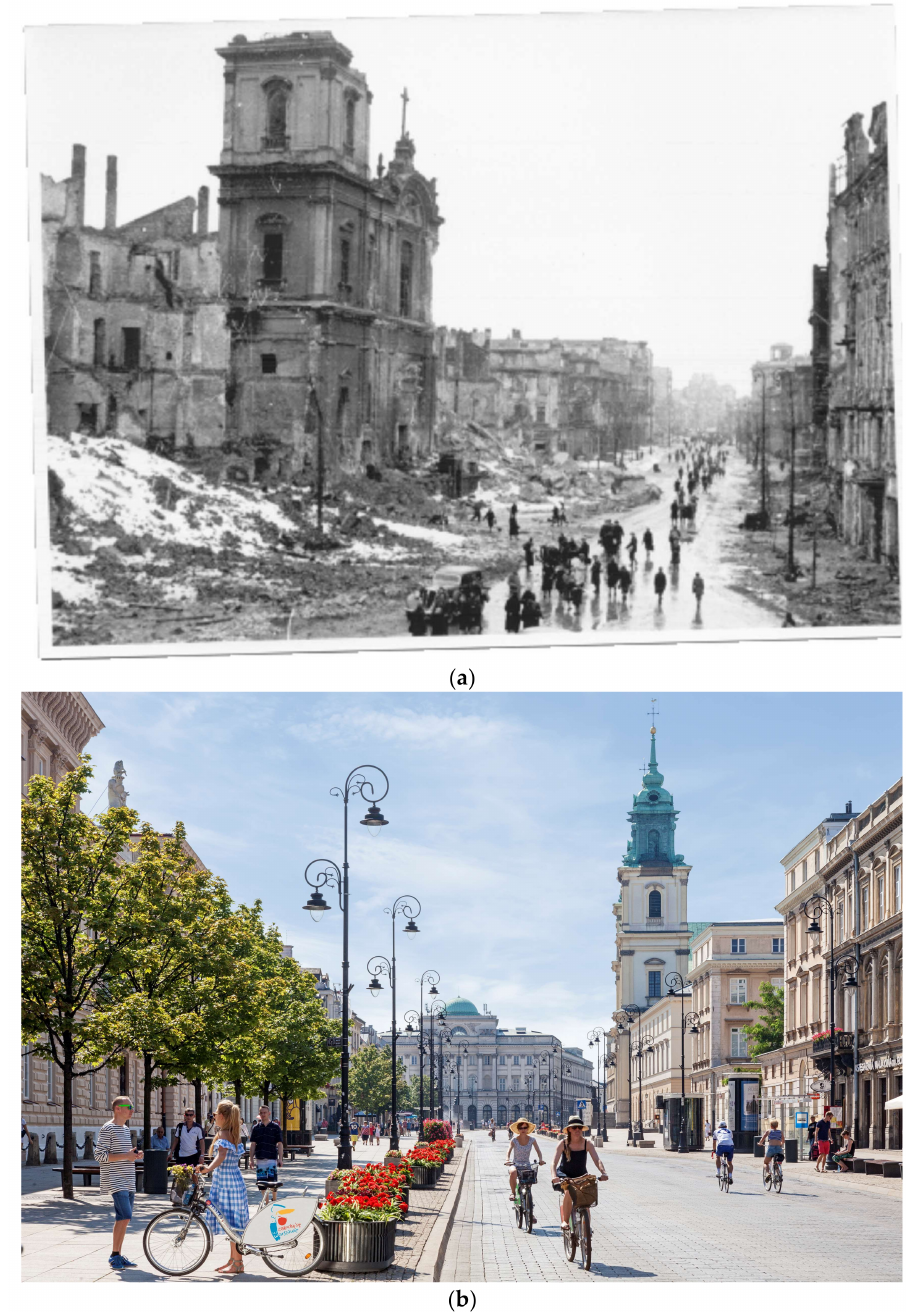
Figure 8. Krakowskie Przedmie´scie St, Warsaw, ( a ) in 1945 (photo: Sylwester Braun, public domain) and ( b ) in 2017 (reproduced with permission from the City of